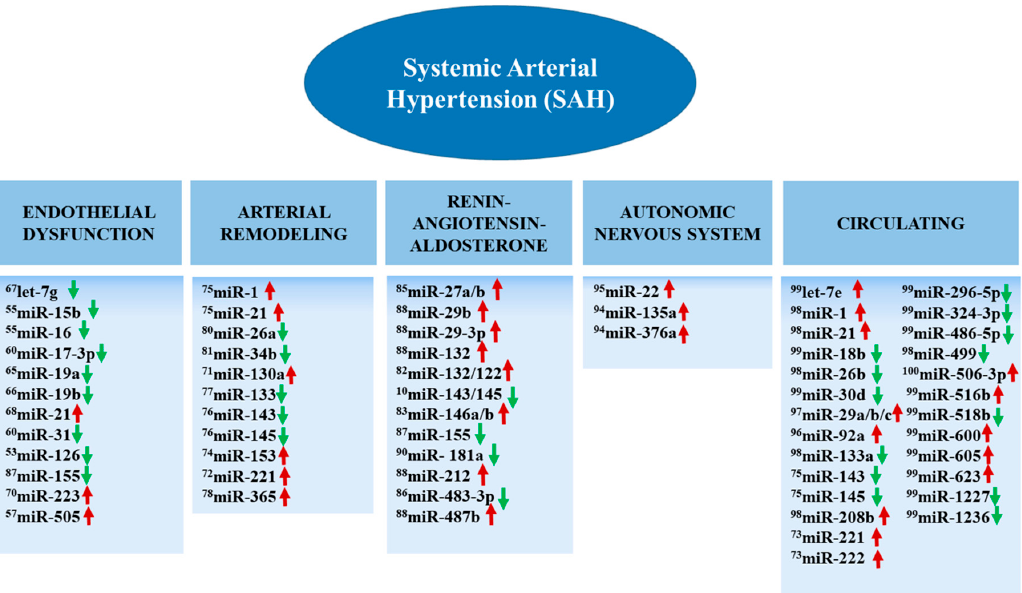
Figure 1. The dysregulated miRNA profile in Hypertension. The diagram shows the miRNA expression pattern associated with different pathophysiological mechanisms involved in hypertension, including endothelial dysfunction, arterial remodeling, renin-angiotensin-aldosterone system (RAAS), and autonomic nervous system. Circulating miRNAs evaluated in serum, plasma, whole-blood, or mononuclear cells, in clinical studies, are also listed. ↑ = upregulated, ↓ =